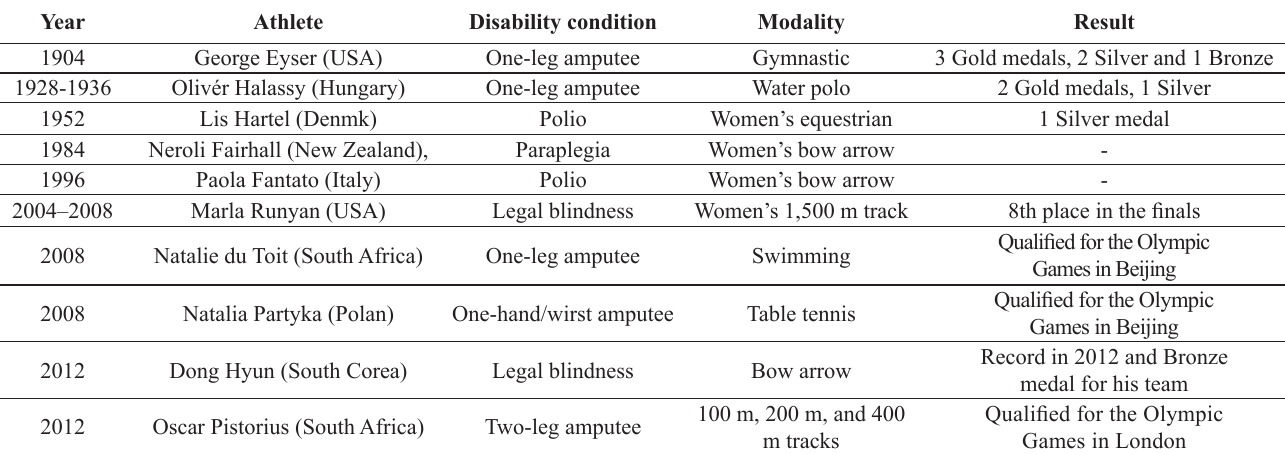
Table 1. Athletes with disabilities who participated in the Olympic Games.